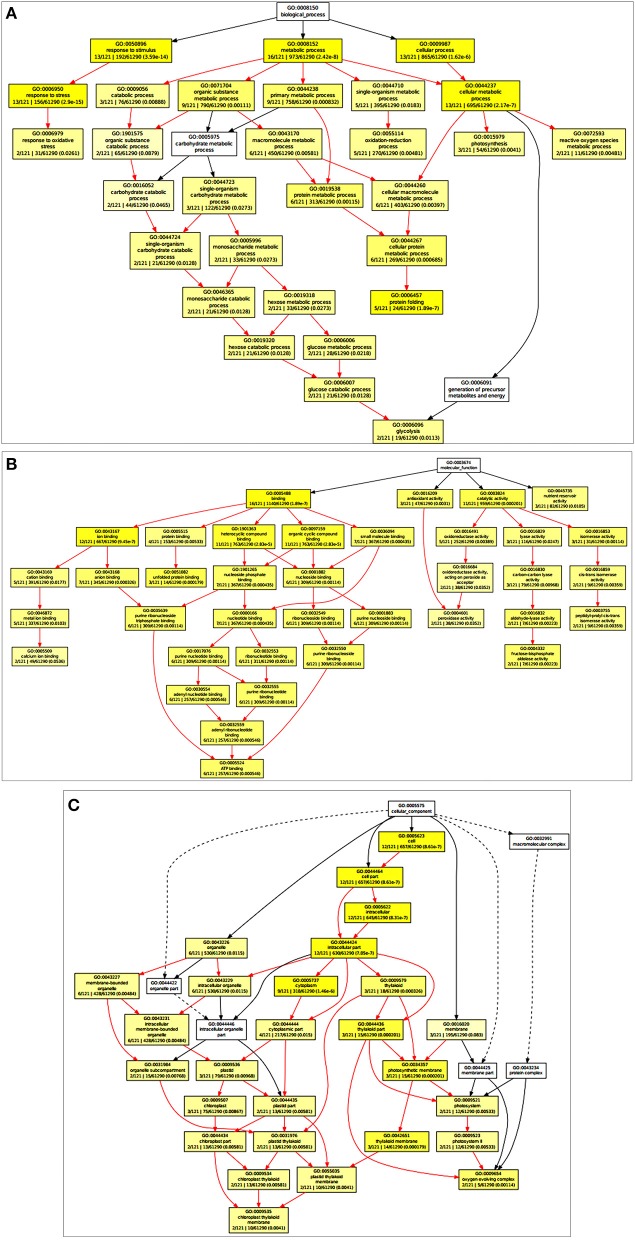
Gene Ontology Enrichment Analysis Software Toolkit (GOEAST) analysis of the cloned Expressed Sequence Tags (ESTs) to generated separate graph for each of the three GO categories, i.e., biological process, molecular function and cellular component. (A) ESTs associated with biological process category with significant p-value, (B) ESTs associated with molecular function, (C) ESTs associated with cellular component with high enrichment.